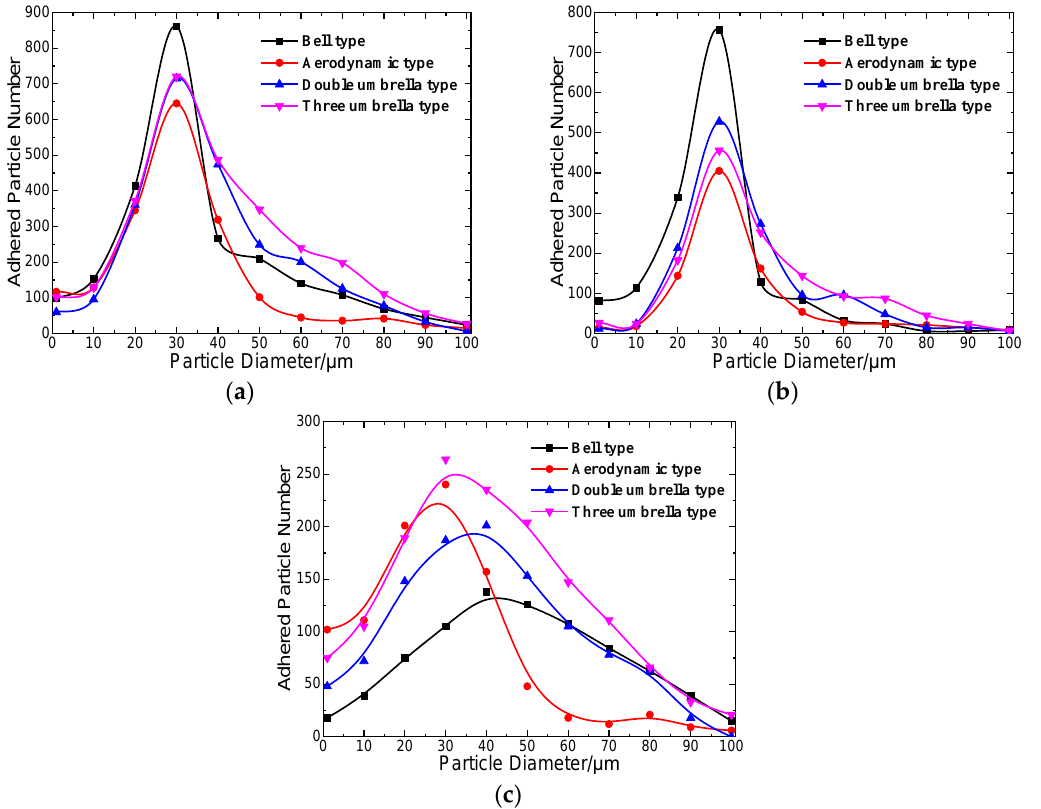
Figure 9. Adhesion number of particles with different size under different electric field strength: ( a ) all surface; ( b ) upper surface; and ( c ) bottom surface. Coatings 2018 , 8 , x FOR PEER REVIEW